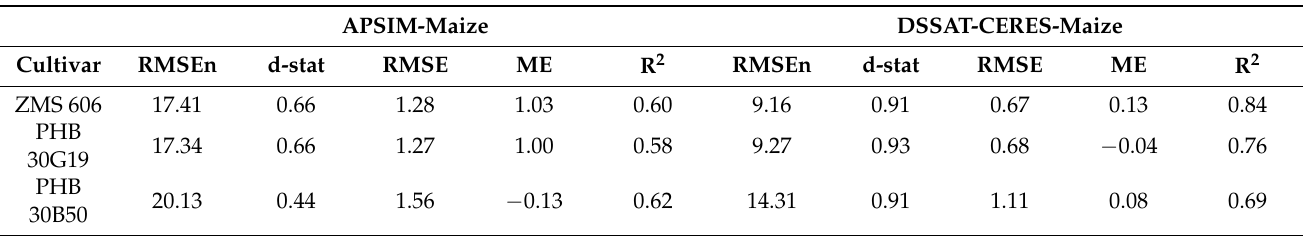
Table 9. The APSIM-Maize and DSSAT-CERES-Maize model calibration statistics for the grain yield for the maize cultivars under rainfed conditions.